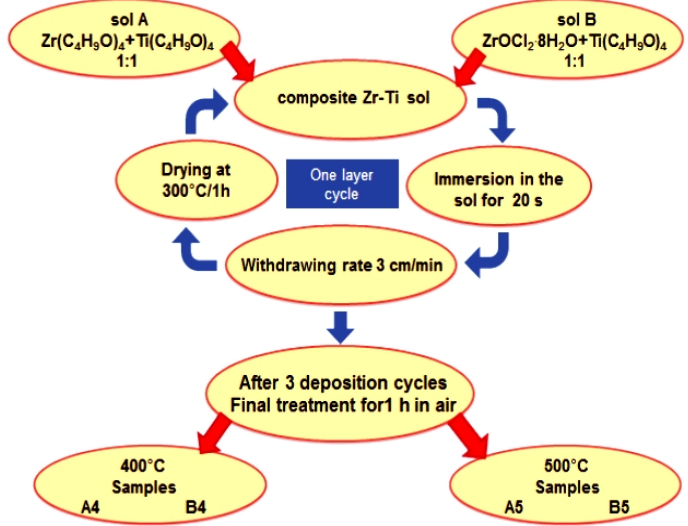
Figure 1. Experimental scheme for deposition of ZrO 2 –TiO 2 coatings.